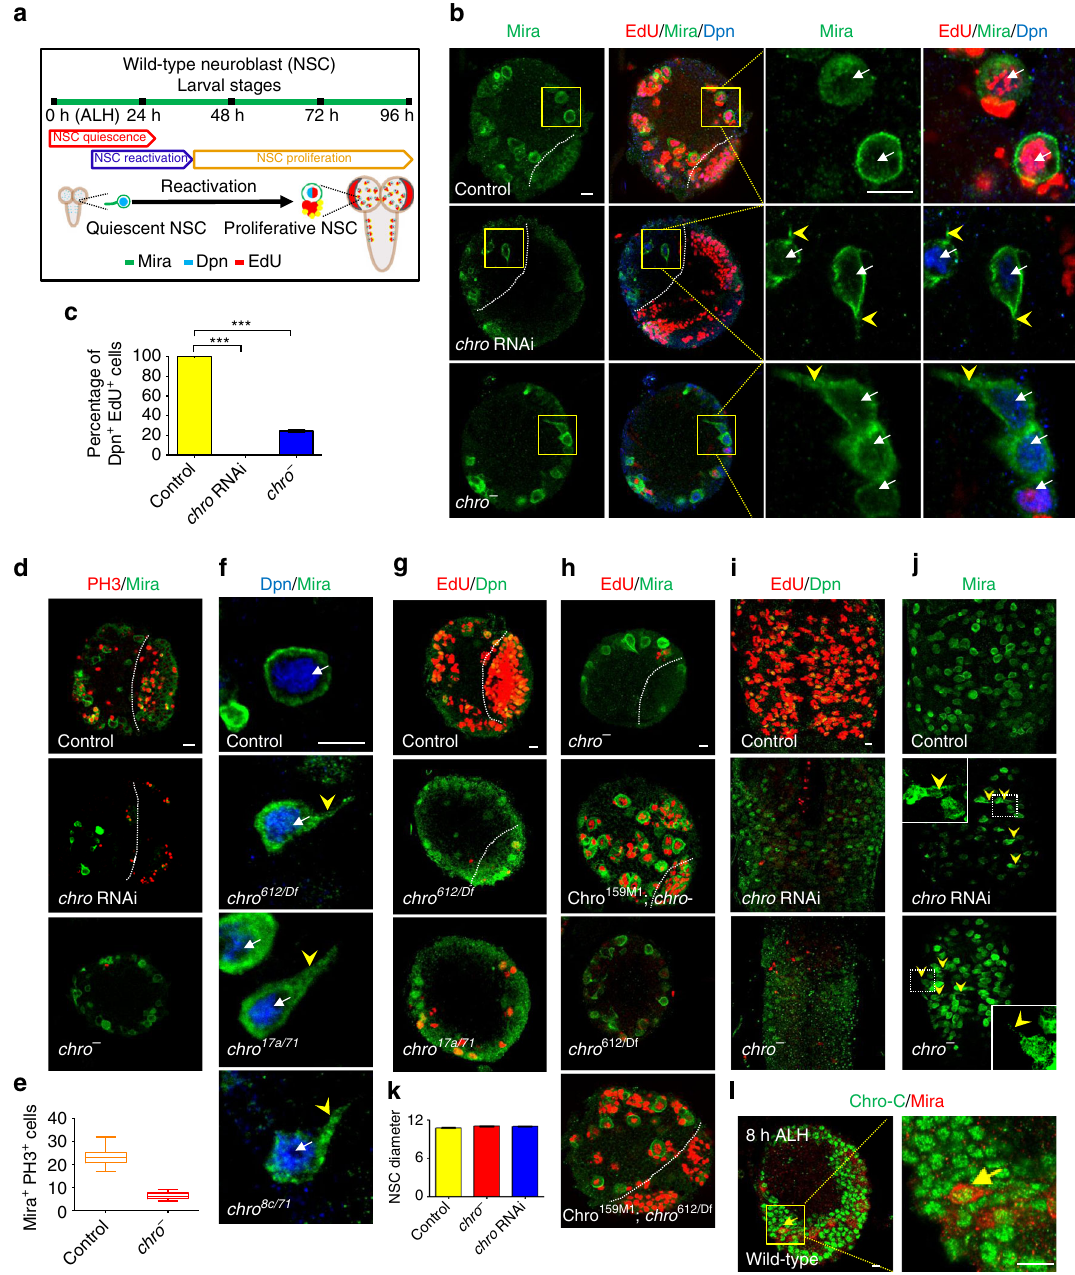
Fig. 1 Loss of chro function resulted in NSCs quiescence in larval brains. a Schematic illustration of timing of reactivation in wild-type larval brain NSCs. b Third-instar larval brains in control, chro RNAi knockdown and chro − NSCs were labelled with Mira, Dpn and EdU. The right panels are enlarged views of the yellow boxes in the left panels. chro − is a trans-heterozygous mutant between chro 71 , an N-terminal 71 amino acids truncation, and chro 612 , a truncated Chro retaining its N-terminal 612 amino acids. c Quanti fi cation of percentages of Dpn + EdU + cells in various genotypes. d PH3 and Mira were labelled in control, chro RNAi knockdown and chro − mutant. e Quanti fi cation of numbers of PH3 + Mira + cells in control (23 ± 4, n = 22) and chro − (6 ± 2, n = 21) larval brains. f Mira and Dpn were labelled in control, chro 612 /Df(3L)ED231( chro 612/Df ), chro 17a/71 and chro 8c/71 NSCs. g Dpn and EdU were labelled for control, chro 612/Df and chro 17a/71 larval brains. h BAC clone CH322-159M1 containing genomic DNA encompassing wild-type chro and its promoter region (Chro 159M1 ) was introduced into chro − or chro 612/Df mutant background. Dpn and EdU were labelled in chro − , Chro 159M1 ; chro − , chro 612/Df and Chro 159M1 ; chro 612/Df larval brains. i Dpn and EdU were labelled in the VNC of control, chro RNAi knockdown and chro − mutant. j Control, chro RNAi and chro − mutant VNCs were labelled with Mira. Insets are enlarged view of the white dotted boxes . k Quanti fi cation of the diameter of third-instar larval NSCs in control, chro RNAi and chro − mutant. NSC diameter: control, 10.7 ± 0.1 µ m; n = 102; chro RNAi, 11.0 ± 0.1 µ m; n = 101 and chro − mutant, 11.0 ± 0.1 µ m; n = 103. l Mira and Chro were stained in wild-type larval brains at 8 h ALH. The right panel is enlarged view of the yellow box in the left panel. Yellow arrow indicates wild-type quiescent NSC. All error bars indicate ± SD. in c , e and k . *** indicates P < 0.001 in c by Student ’ s t -test. The central brain is to the left of the white dotted line in b , d , g , h . Arrows indicated NSCs and arrowheads indicated the cellular extension of NSCs in b , f and j . Scale bars, 10 µ